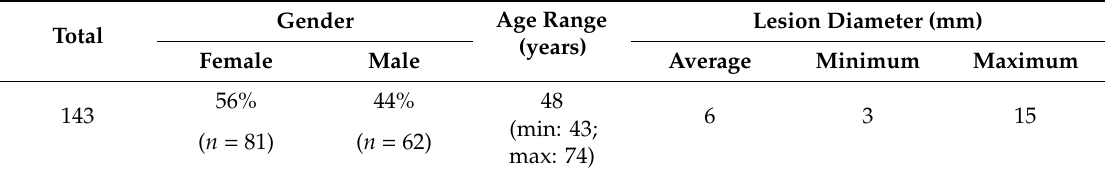
Table 1. Clinical features of the treated patients.